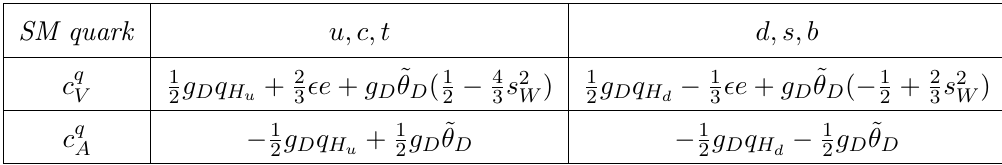
Table 3 . Axial and vector couplings for SM quarks in a 2HDM scenario.